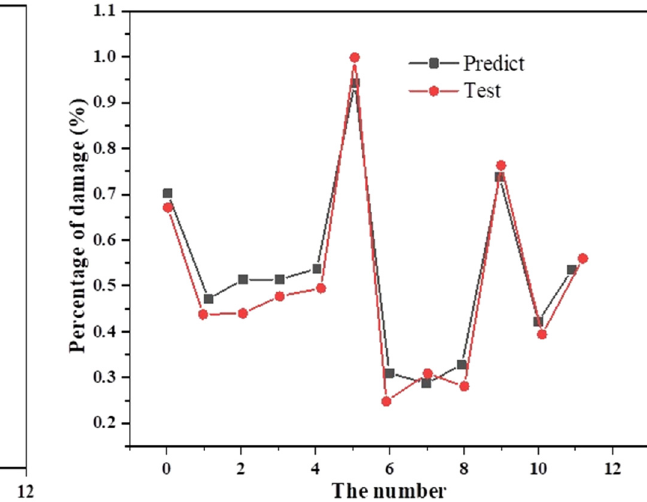
Figure 3: Fitting degree of bridge damage at 150 mm.